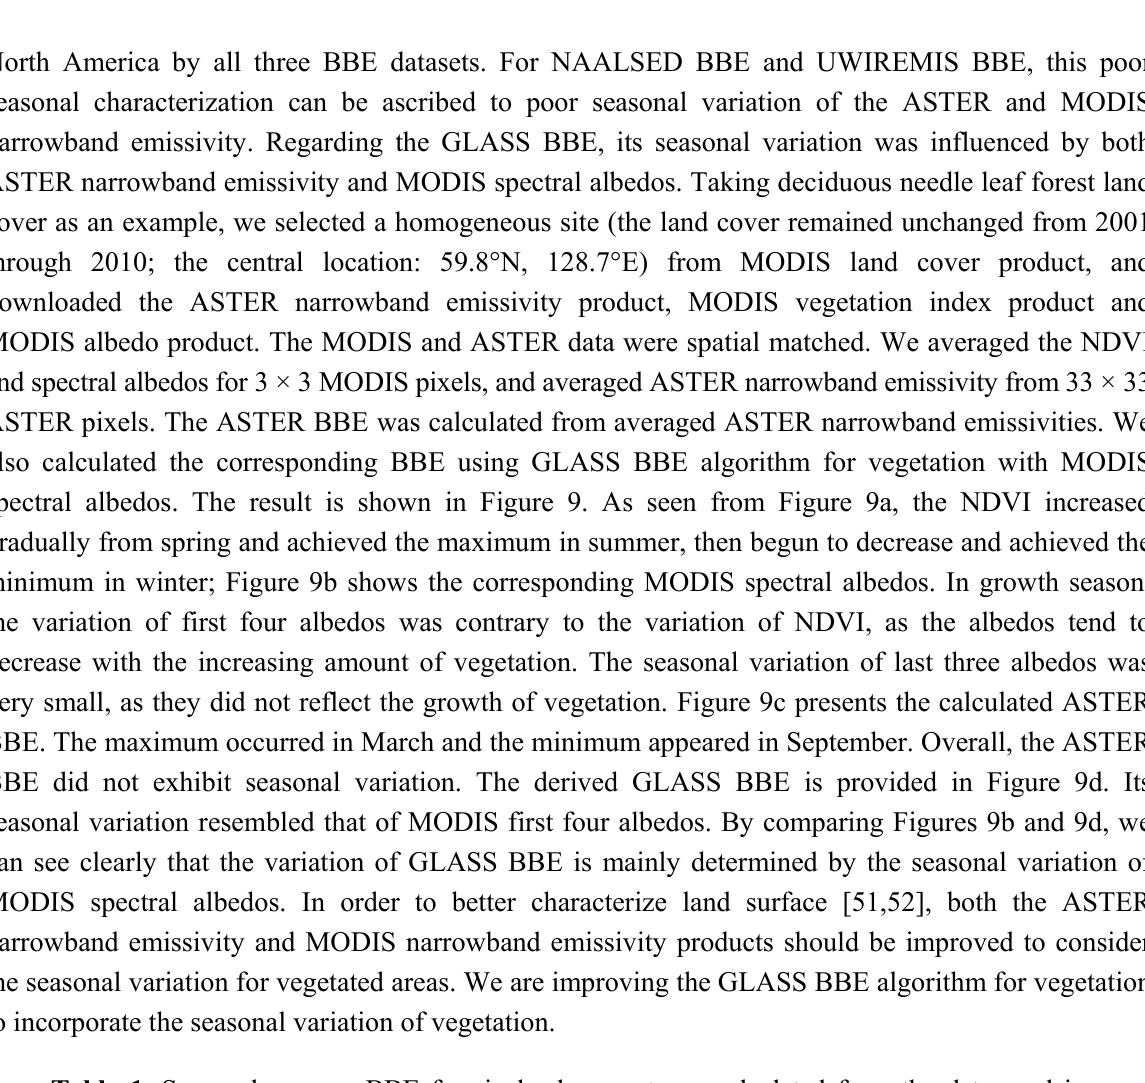
Table 1. Seasonal average BBE for six land cover types calculated from the data used in Section